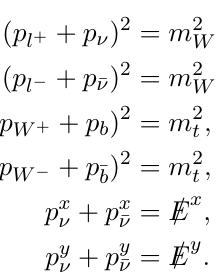
Figure 10. Distributions of the BDT (left) and BDTG (right) discriminants for the signal and background in training and test samples, for t (cid:22) tA events with m A = 40